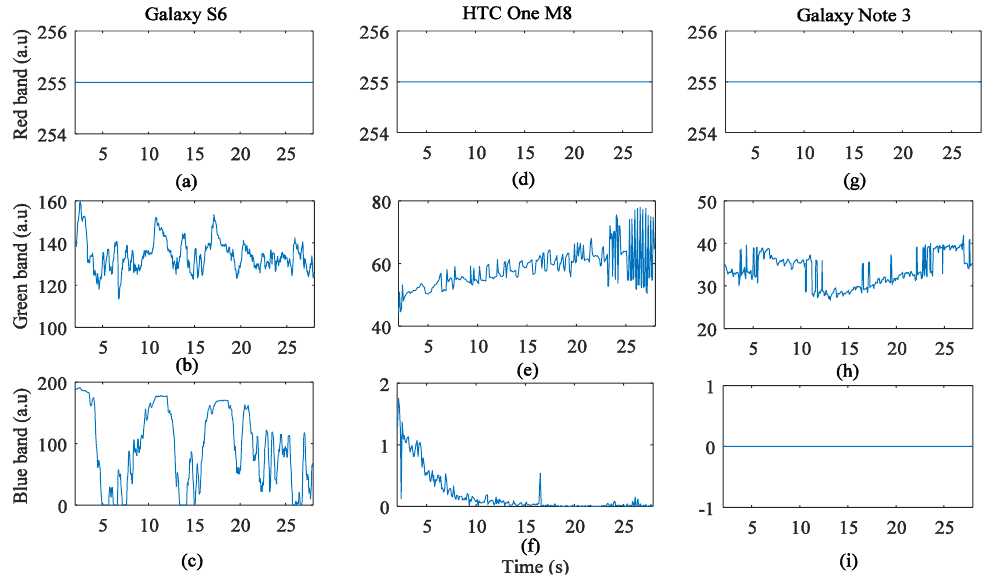
Figure 11. PPG signals with a fingertip pressure force: ( a ) Signal of the red color band of Galaxy S6; ( b ) Signal of the green color band of Galaxy S6; ( c ) Signal of the blue color band of Galaxy S6; ( d ) Signal of the red color band of HTC One M8; ( e ) Signal of the green color band of HTC One M8; ( f ) Signal of the blue color band of HTC One M8; ( g ) Signal of the red color band of Galaxy Note 3; ( h ) Signal of the green color band of Galaxy Note 3; ( i ) Signal of the blue color band of Galaxy Note 3.